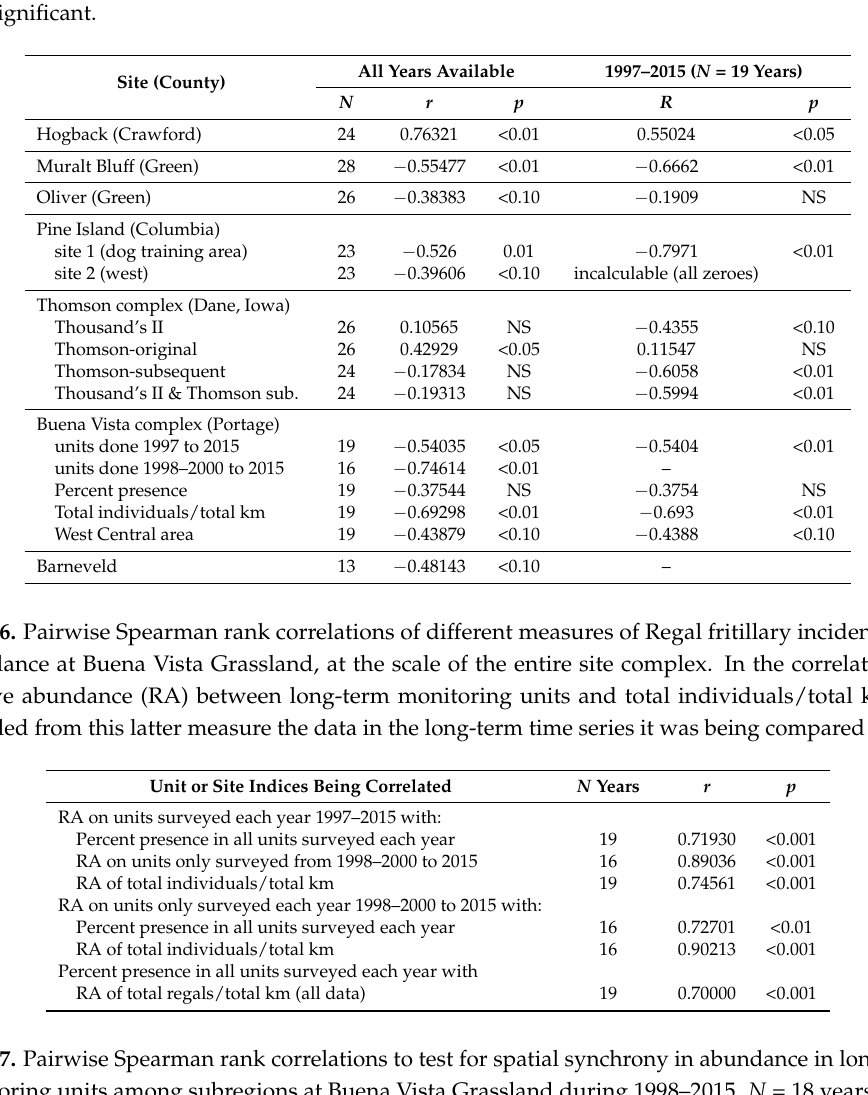
Table 5. Spearman rank correlations of trend (abundance vs. year). These were calculated for populations (sites where regal fritillaries were recorded in more than one year in this study) surveyed >12 years, with county in parentheses. NS = not significant ( p > 0.10). p < 0.10 is considered near significant.